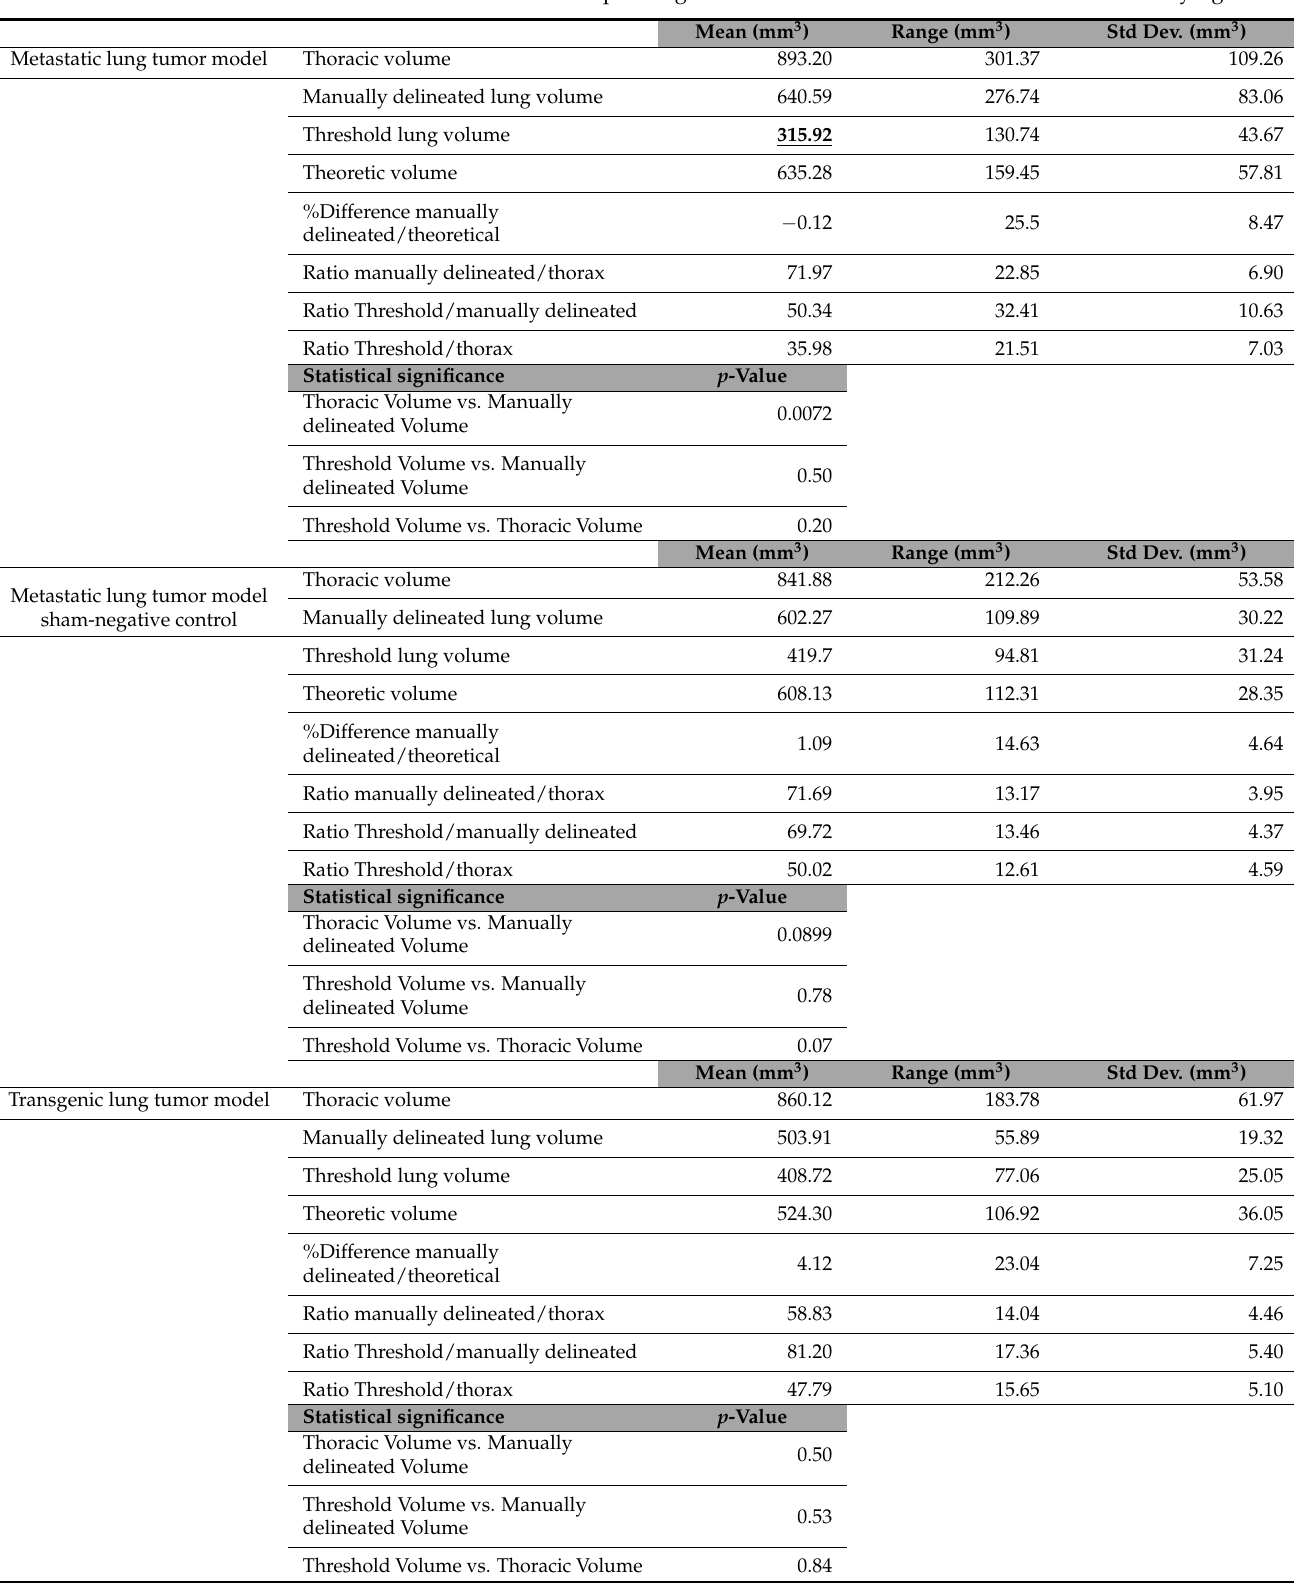
Table A3. Statistical results of pathologic models. Bold and underlined values are statistically